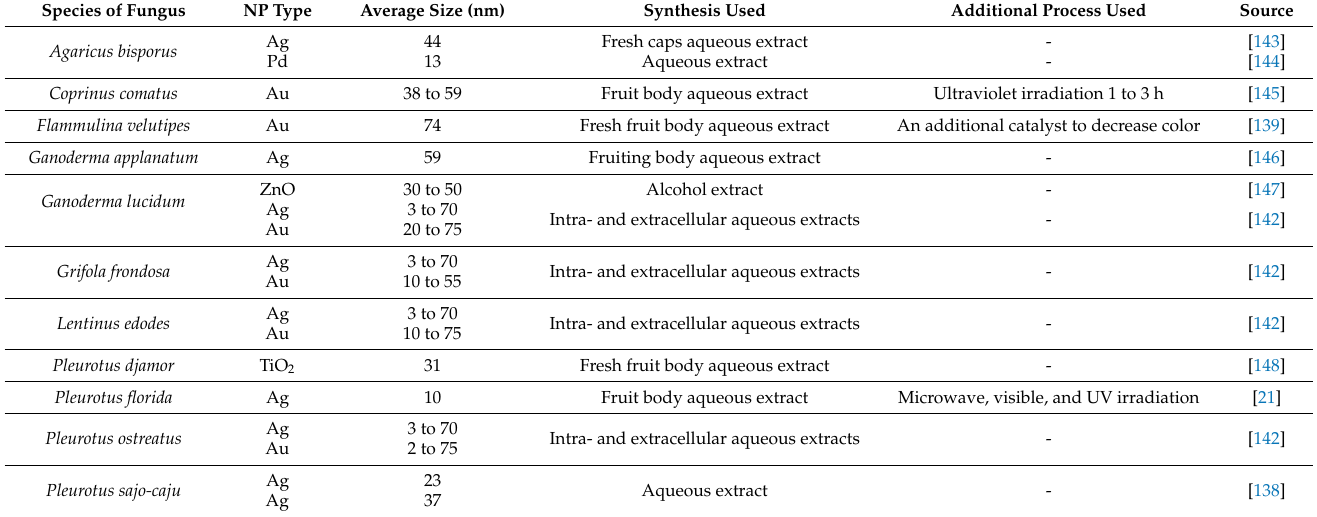
Table 3. Selected examples of basidiomycetes used in the synthesis of various metal-containing